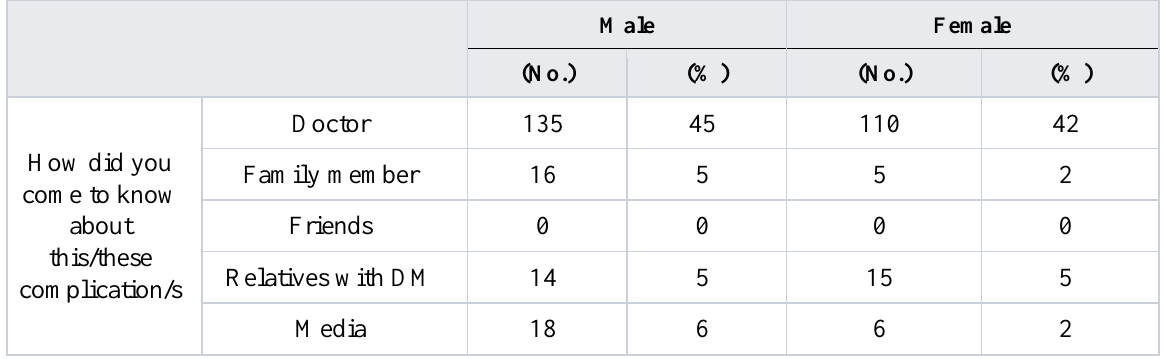
Table (3): The studied sample according to their practice person with diabetes undergo an eye checkup